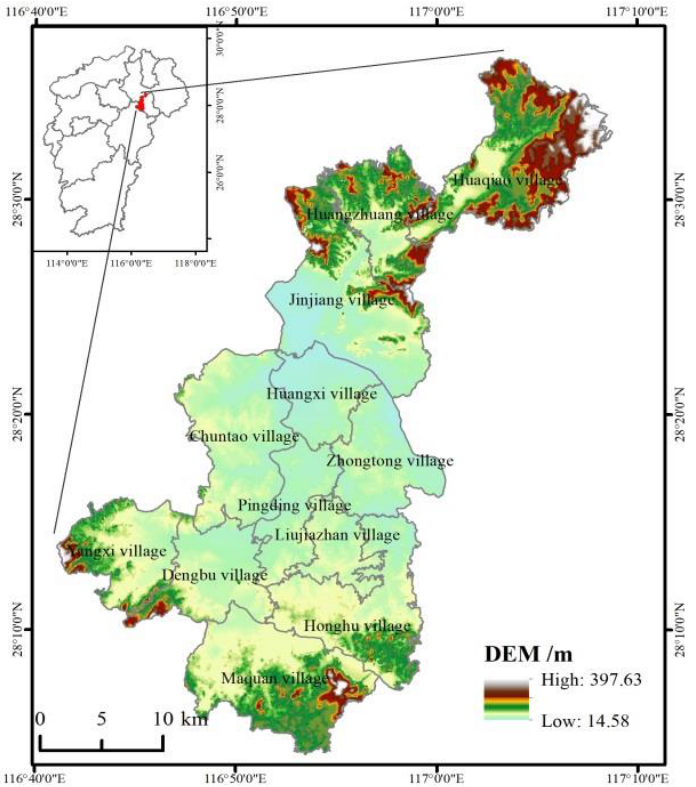
Figure 1. Geographical location of the study area — Yujiang District, Yintan City, Jiangxi Province, China.